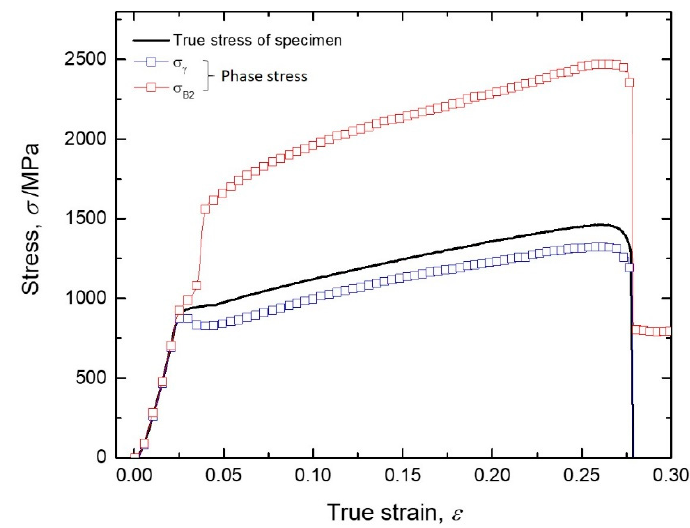
Figure 7. Calculated phase stresses of austenite and B2 phase are plotted as a function of tensile true strain. The true stress-strain curve of the specimen is also plotted. A significant stress partitioning between the austenite phase and the B2 phase during plastic deformation can be readily observed.